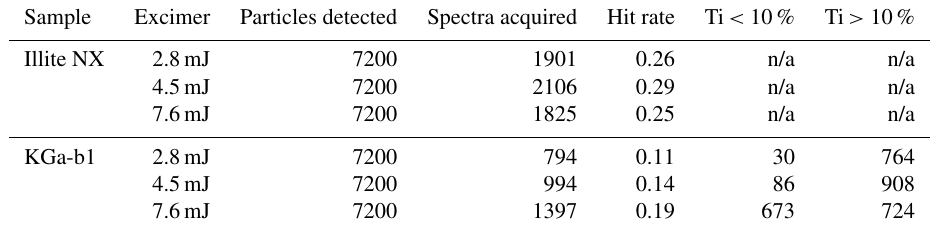
Table 7. The effect of the excimer pulse energy setting on the particle hit rate with illite NX and kaolinite sample KGa-1b. The number of particles that are low ( < 10% peak area) and high ( > 10% peak area) in titanium are given for the KGa-1b sample. The titanium content in the mass spectra was calculated from the combined peak area of the Ti + ( m/z 48) and TiO + ( m/z 64) and the total positive ion signal (n/a = not applicable).